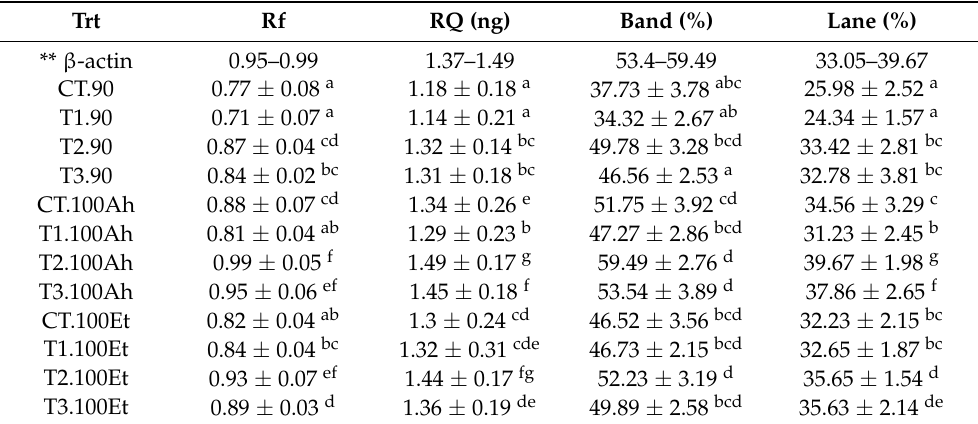
Table 3. Showing densitometry parameters of the ISG 15 gene.